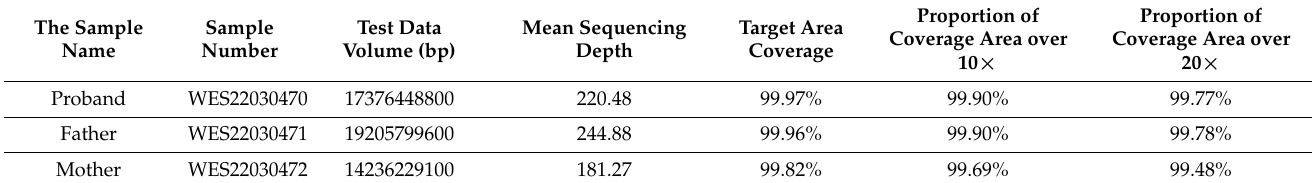
Table 2. Sequencing quality statistics of the target region.